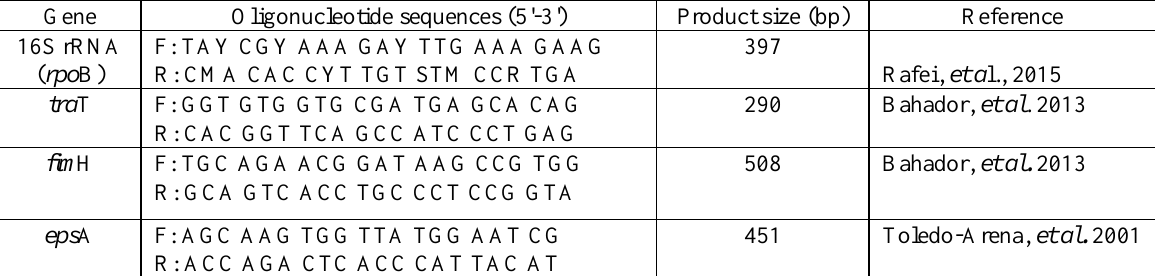
Table 1: The oligonucleotides primer sequences used for molecular identification of Acinetobacter species